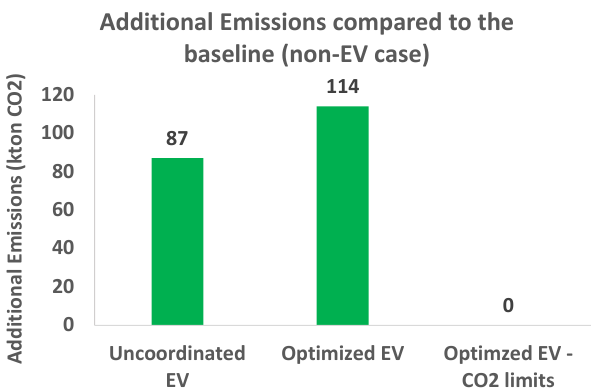
Figure 14. Additional emissions (kton CO 2 ) compared to the baseline scenario that considers no EVs for different charging schemes for the case study of the Maldives islands [46].